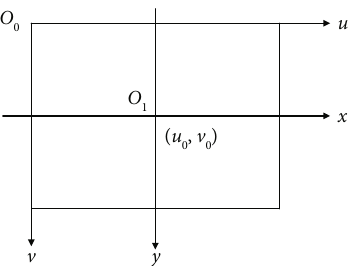
Figure 6: The relationship diagram between the image and the pixel coordinate